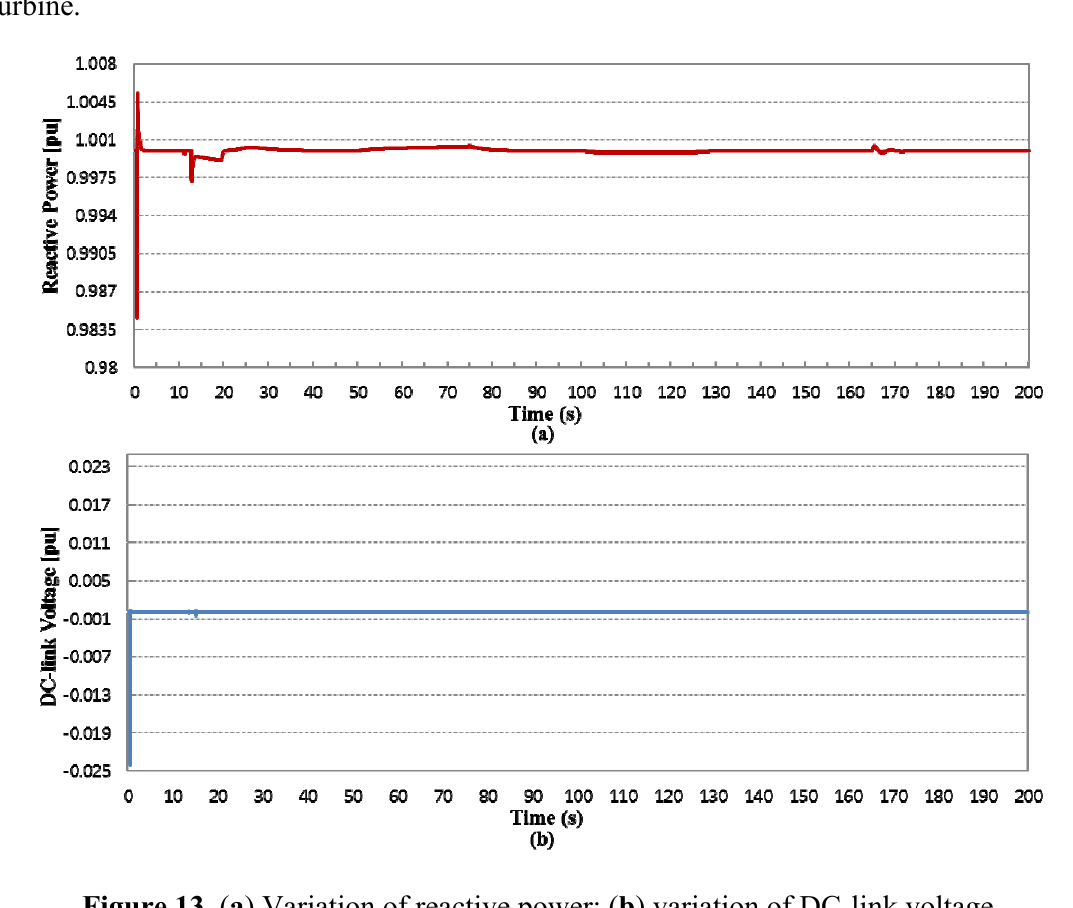
Figure 13. ( a ) Variation of reactive power; ( b ) variation of DC-link